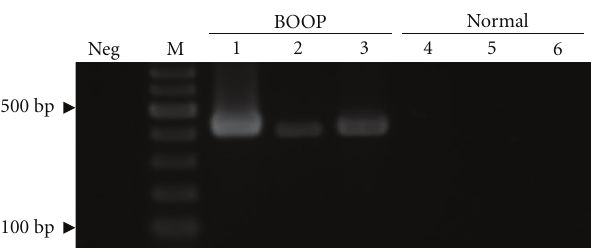
Figure 1: Detection of porcine circovirus type 2 (PCV2) with PCR method. The primers designed on the basis of the ORF2 of the PCV2 virus genome to produce a 416 bp long amplicon. The BOOP lung tissues from five pigs were positive. In the agarose gel, three representative cases were shown. Neg: negative control. M: